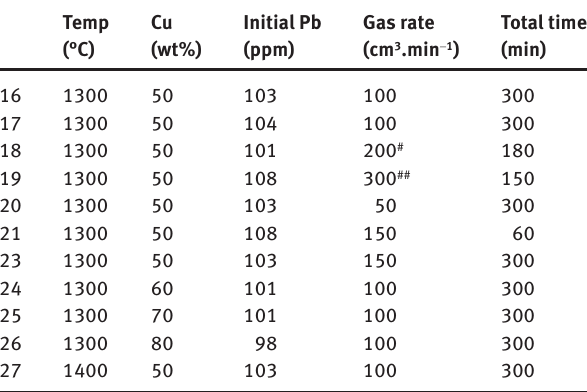
Table 1: Conditions for the transport experiments using argon gas